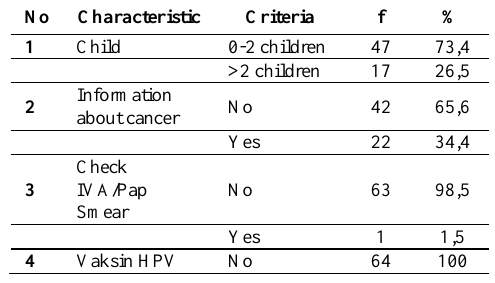
Table 2. Reproduction history (n=64)